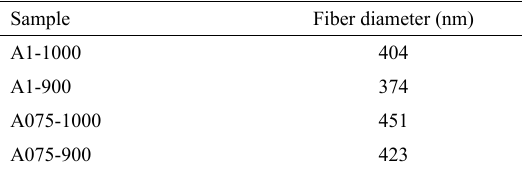
Figure 6. Fibers diameter distribution. Table 2. Average fiber diameter.